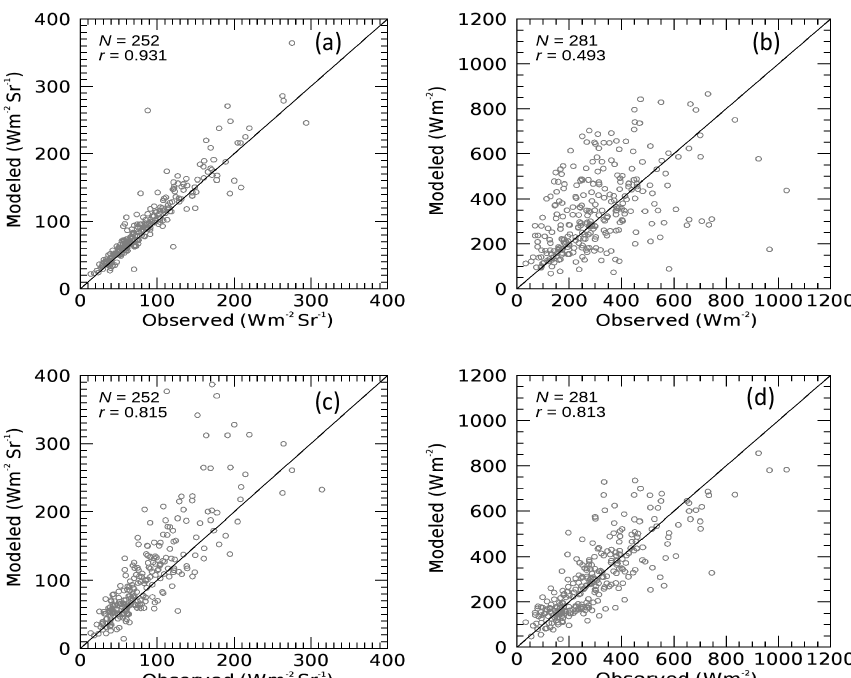
Figure 5. Comparison of modeled and observed broadband (a) radiances and (b) irradiances for modeled values using sky radiometer cloud proprieties for the observation site at Chiba (35.62 ◦ N, 140.10 ◦ E) for 2016. Comparison results for broadband radiances (c) and (d) the irradiance for modeled cloud properties corresponding to the Advanced Himawari Imager.